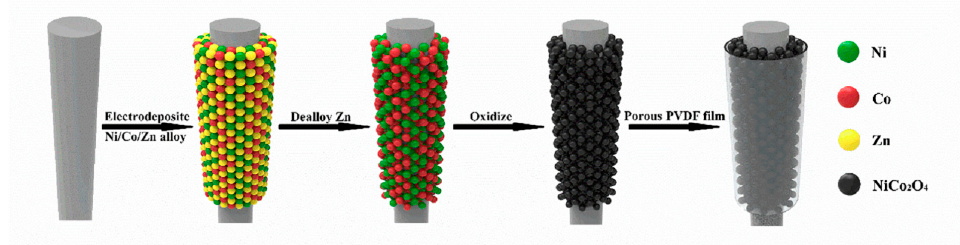
Figure 7. Schematic process showing the synthesis of porous polyvinylidene fluoride (PVDF)/NiCo 2 O 4 coated on ultrafine nickel wire by electrodeposition and dealloying. Reproduced with permission from [162]. Copyright 2018 Elsevier.